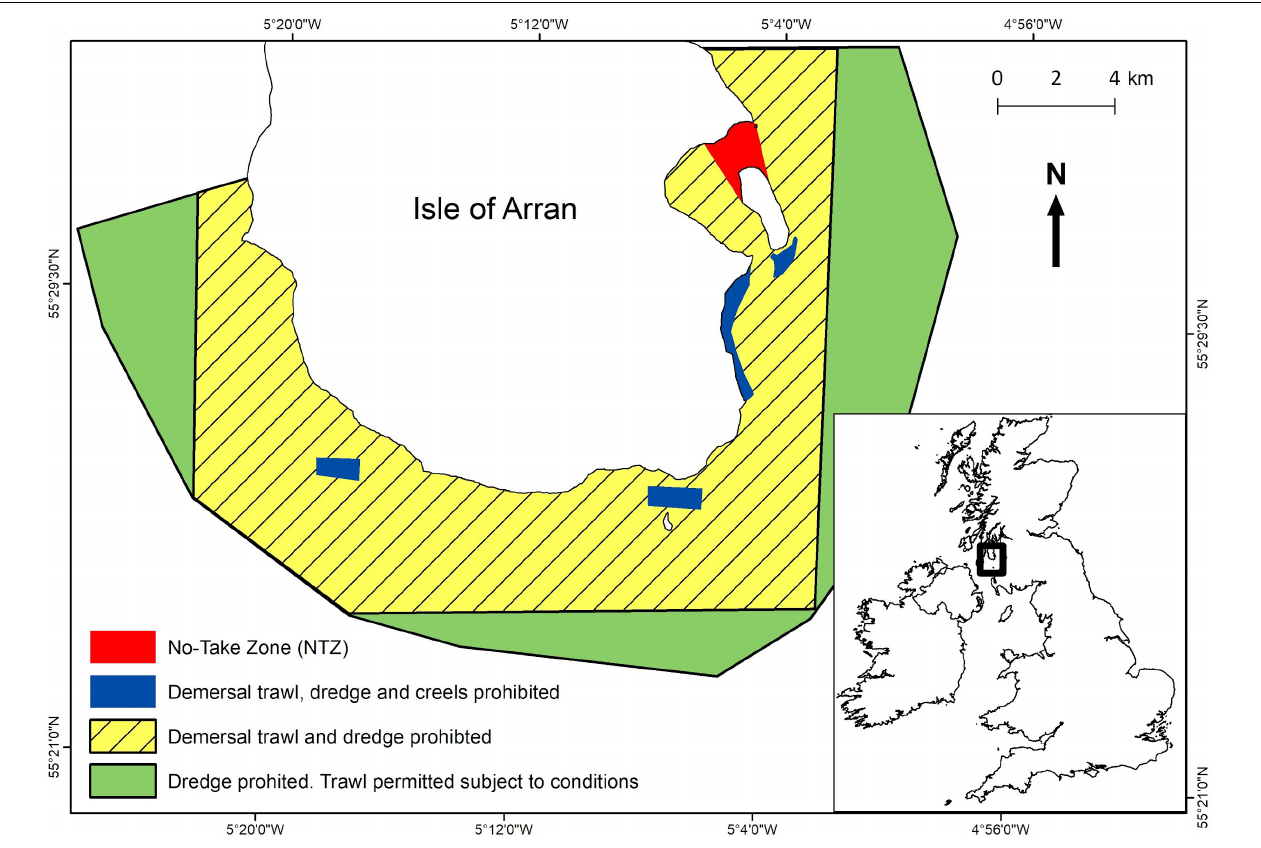
FIGURE 3 | Map of the south of the Isle of Arran and the various management measures inside the South Arran Nature Conservation MPA, as from February 2016. Inset shows the area in relation to the United Kingdom.